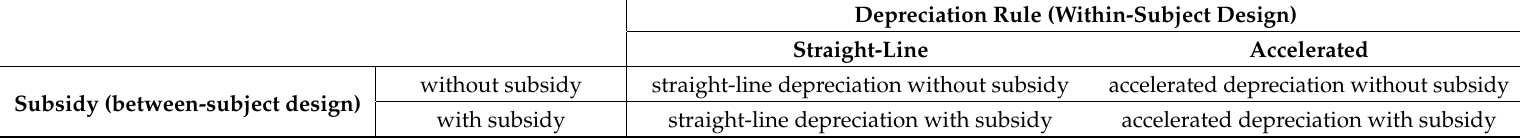
Table 1. Treatment overview.